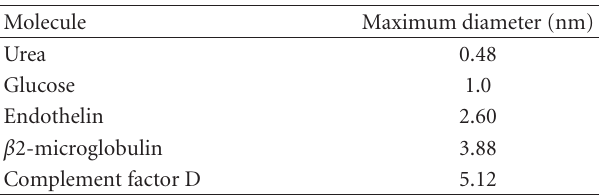
Table 2: Measured maximum diameter of glucose and selected uremic